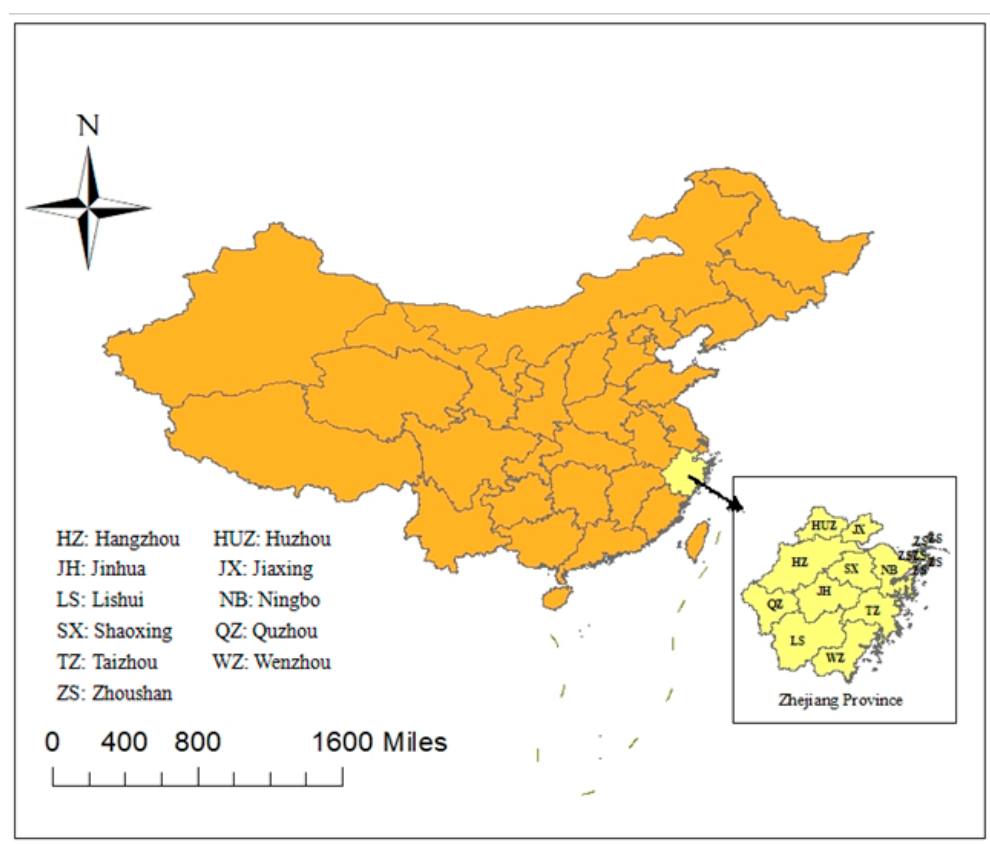
Figure 1. The location of Zhejiang province in China.